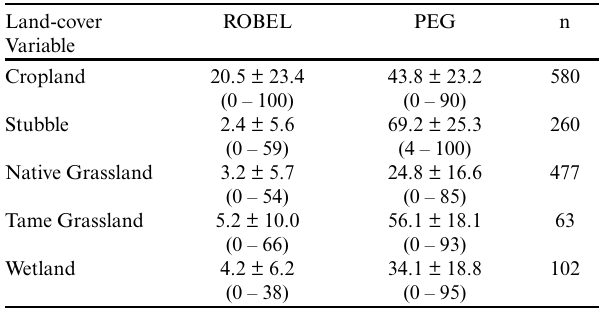
Table 4 . Mean ± 1 standard deviation for ROBEL and percent exposed ground (PEG) for each land-cover class. Numbers in brackets are the range.